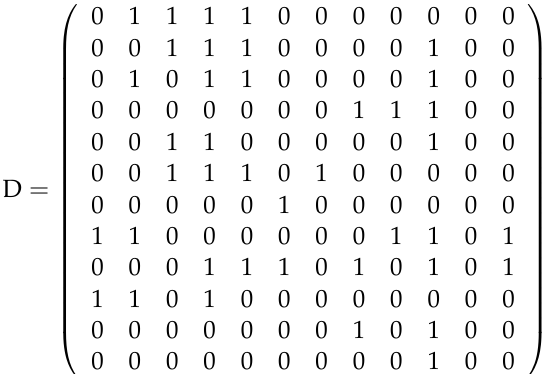
Have strong influence on Si